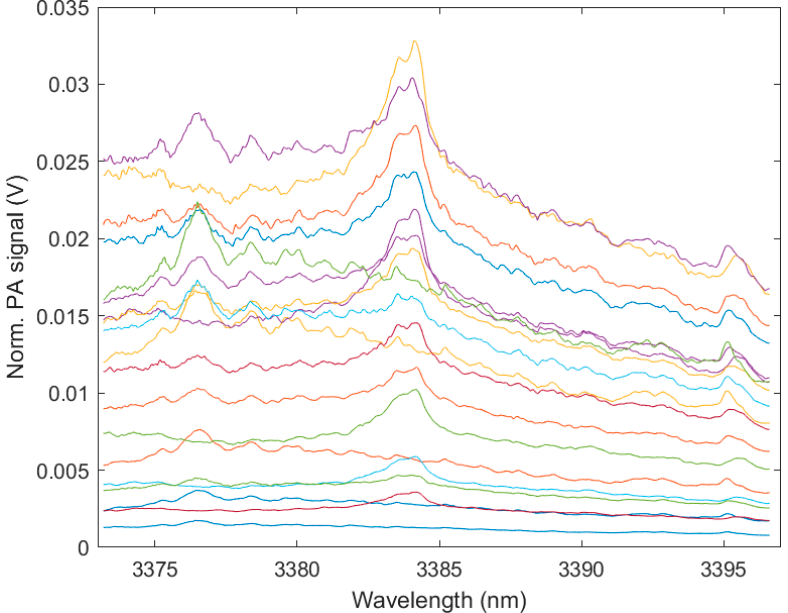
Figure A2. Measured PA spectra (19 different measurements) for multicomponent analysis with ICL 1638.